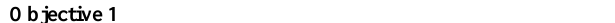
Figure 2 . Proposed expansion of the WHO nursing roadmap global strategy on human resources for health to include all advanced practice providers (APPs.) Adapted from the WHO Roadmap for Nursing